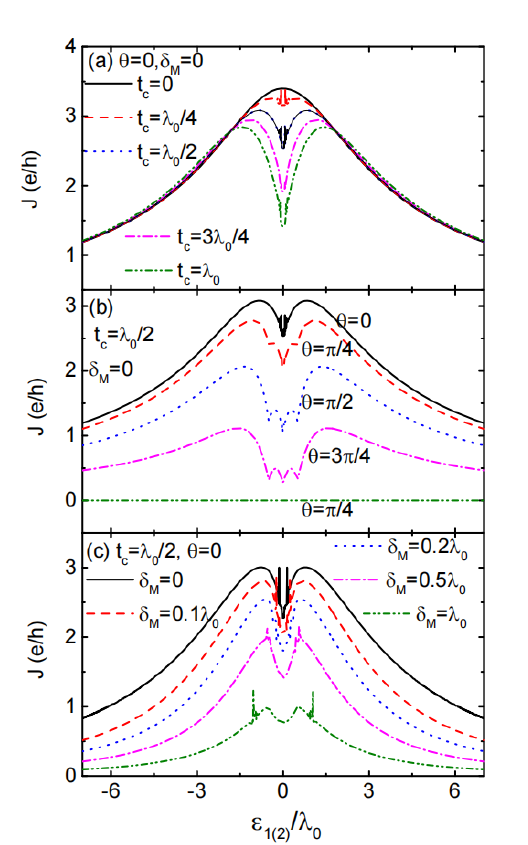
Figure 3. (Color online) Josephson current as a function of identical QDs’ levels ε 1 = ε 2 for fixed ∆ φ = π /2 and different values of t c in ( a ), θ in ( b ) and δ M in ( c ). Other parameters are shown in the